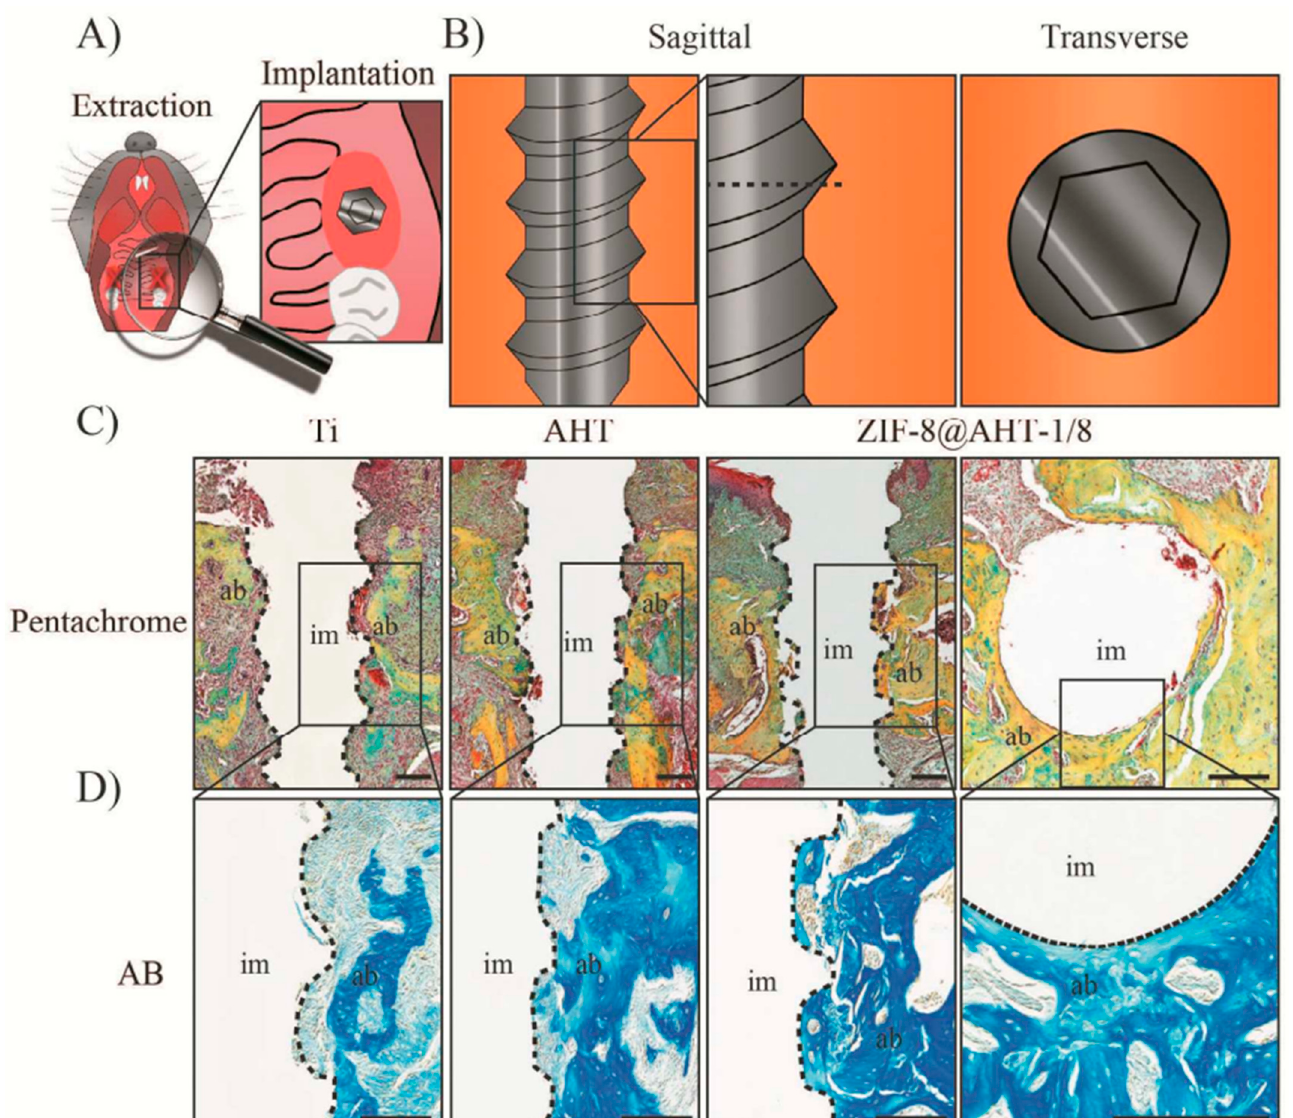
Figure 5. ( A ) Schematic of the surgery; ( B ) Sagittal and transverse direction of the implants placed into osteotomies; ( C ) Pentachrome staining, and ( D ) Aniline blue staining of Ti, AHT, and ZIF- 8@AHT-1/8. Scale bar representing 100 µm; n = 6 per group. Reprinted with permission from [68]. Copyright 2023 American Chemical Society.